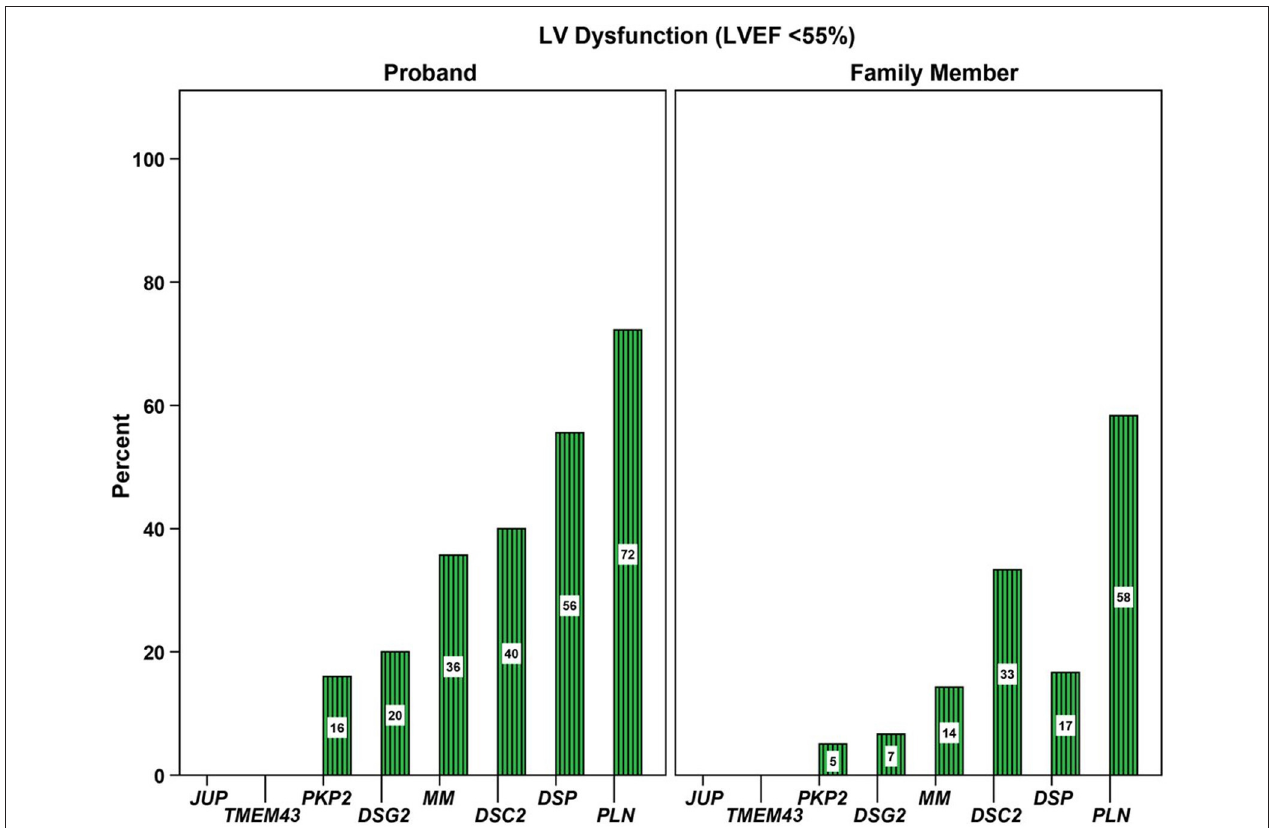
FIGURE 5 | Association of genotype with prevalence of left ventricular (LV) dysfunction. Proportion of 577 gene-positive probands and family members with LV dysfunction stratified by gene with a pathogenic or likely pathogenic variant. LV, left ventricular; MM, more than one P/LP variant, including compound heterozygote, homozygote, and digenic patients. Source: ( 32), obtained with